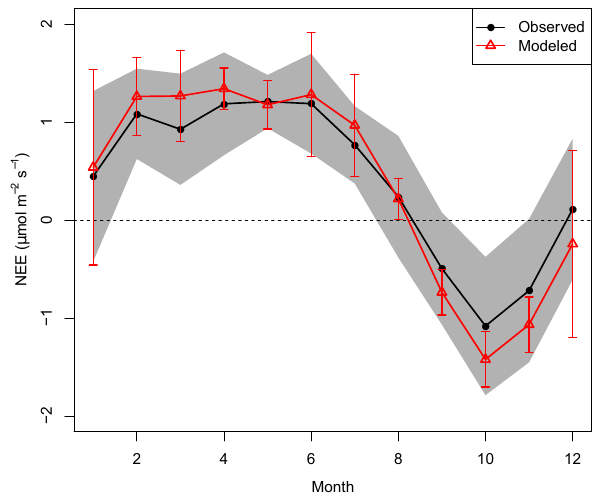
Figure 6. Mean seasonal cycle of NEE obs (black dots) and NEE Model (red triangles). Gray shaded areas are standard devia- tions of interannual variability for the mean NEE obs for each re- spective month. Error bars are standard deviations of the interannual variability in monthly mean NEE Model